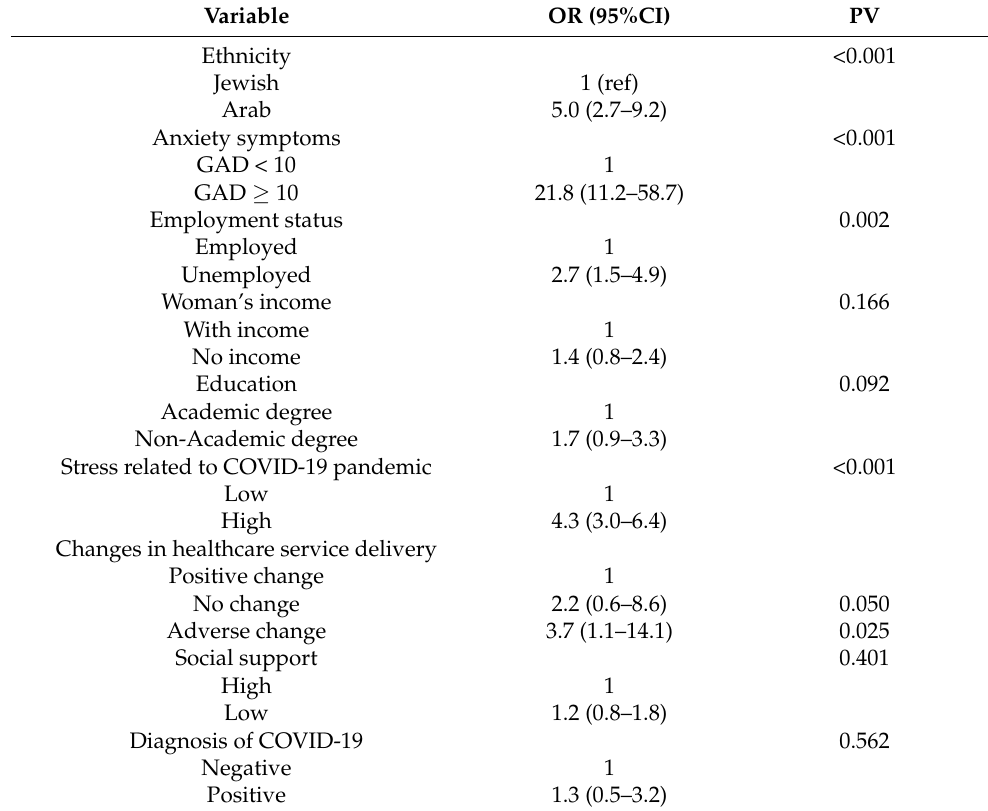
Table 3. Factors associated with PNDS (EPDS ≥ 10) as per multivariate logistic regression